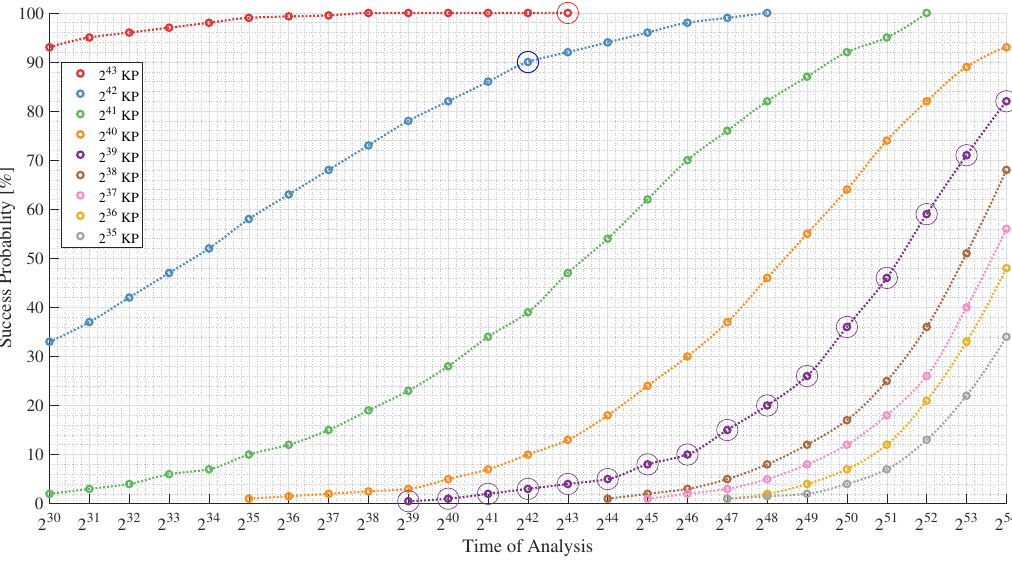
Figure 16: Success Probability of Conditional Linear Cryptanalysis by Known Plaintexts and Time of Analysis (The marked points were experimentally verified on 79 runs of our attack on the full 16-round